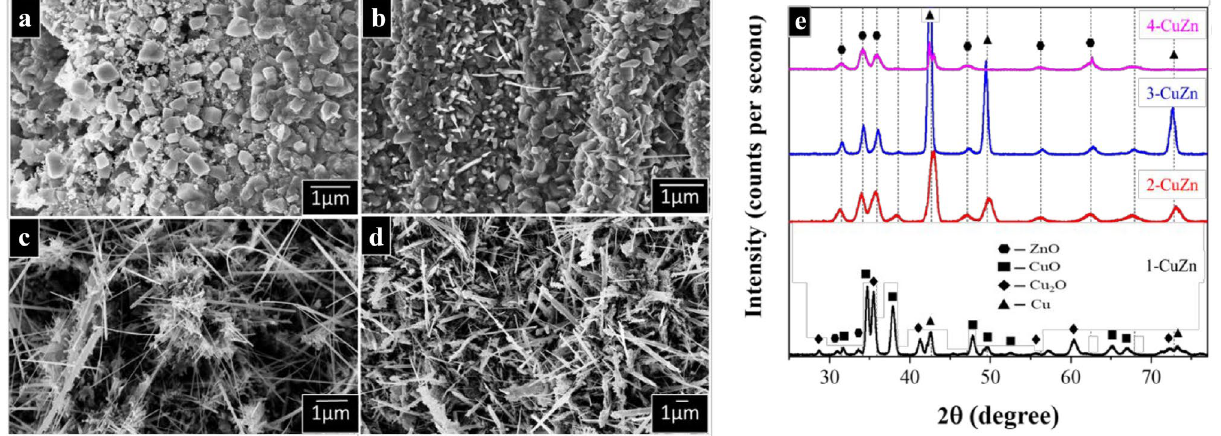
Figure 1. SEM images of the ( a ) 1-CuZn with 5% Zn, ( b ) 2-CuZn with 15% Zn, ( c ) 3-CuZn with 30% Zn, and ( d ) 4-CuZn with 50% Zn samples after annealing in air at 500 °C for 1 h. ( e ) Grazing angle XRD patterns for all 4 samples after annealing at 500 °C for 1 h with 10 °C/min heating